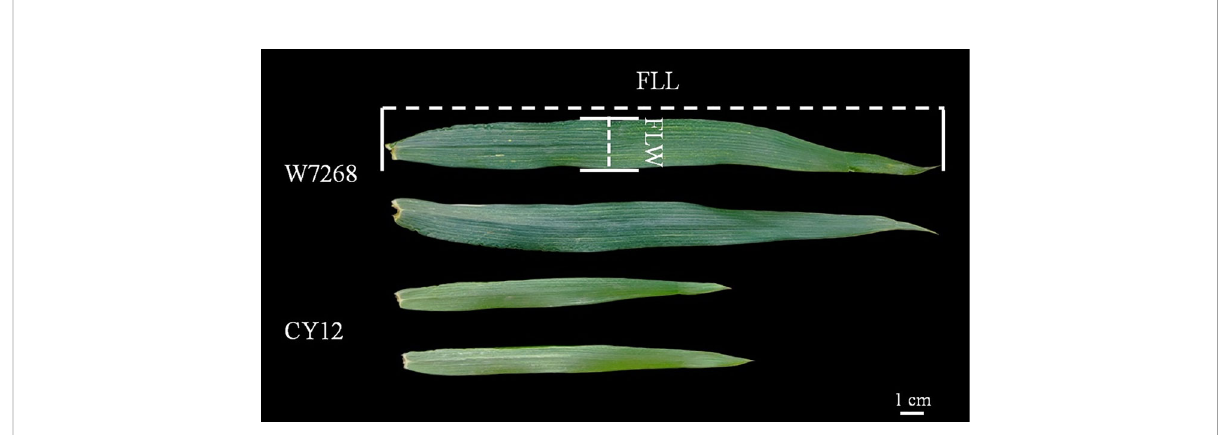
FIGURE 1 Morphology of the fl ag leaf size of W7268 and Chuanyu 12 at fl owering stage from Shuangliu 2020-2021